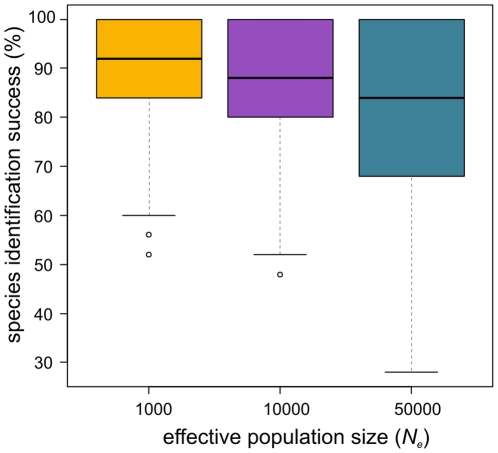
Influence of Effective population size (Ne) on species identification success.Boxplots of percent species identification success (N = 100) based on query data sets simulated under coalescence with effective population sizes of 1000 (yellow), 10000 (purple) and 50000 (blue) individuals.